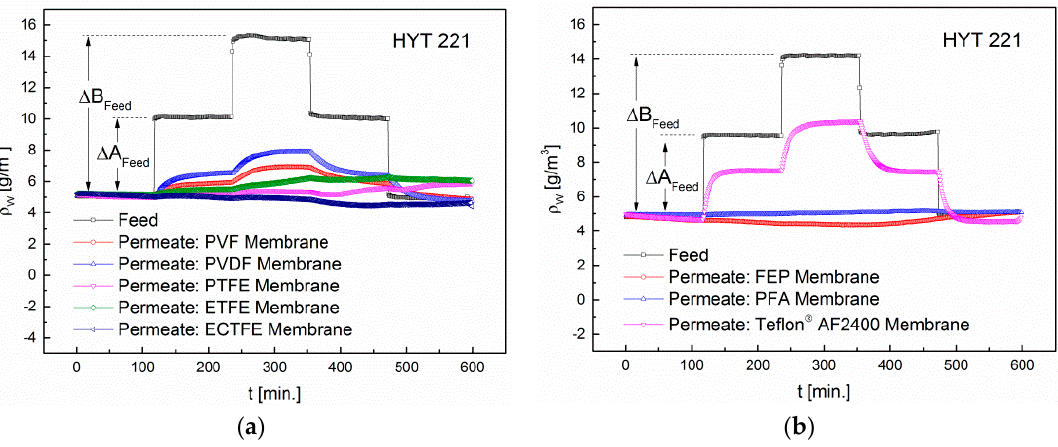
Figure 13. ( a ) Permeability of water vapor in PVF, PVDF, PTFE, ETFE and ECTFE membranes; ( b ) Permeability of water vapor in FEP, PFA, and Teflon ® AF2400 membranes. The absolute humidity was increased in two steps t of 4.8 g/m 3 each.